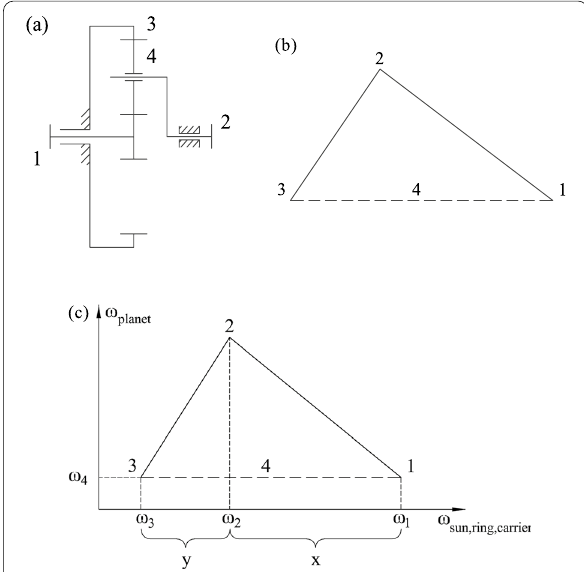
Figure 3 Geometric model of a basic planetary gear set: a Functional diagram, b Geometric model, c Velocity projection in the Cartesian coordinate